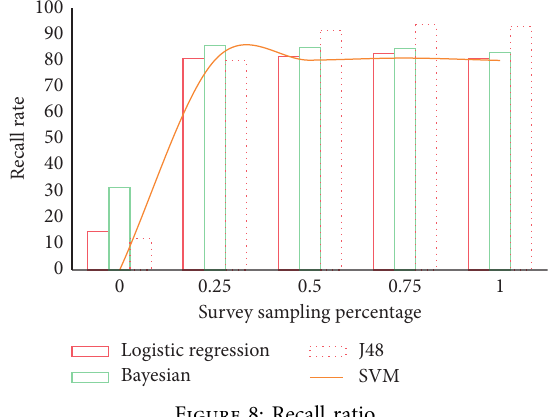
Figure 8: Recall